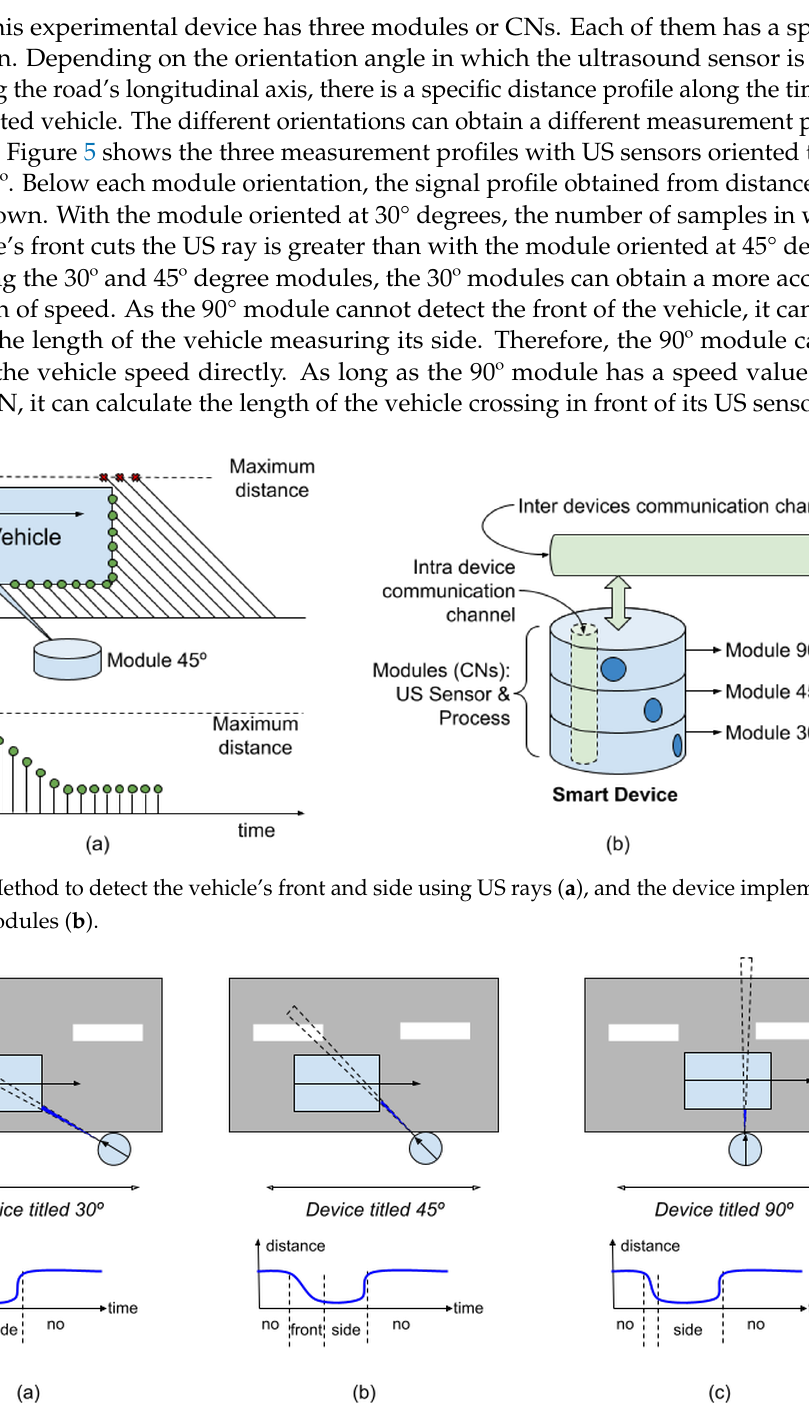
Figure 5. Selected configurations that provide a reasonably accurate estimation of vehicle characteris- tics: 30° ( a ), 45° ( b ), and 90° ( c